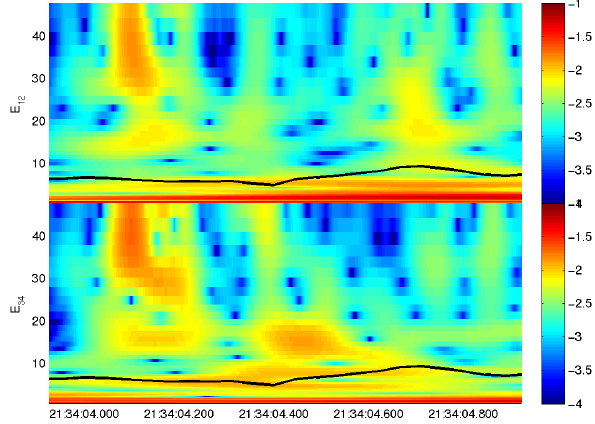
Fig. 7. The wavelet dynamic spectrum for event 2 (using the same format as Fig.